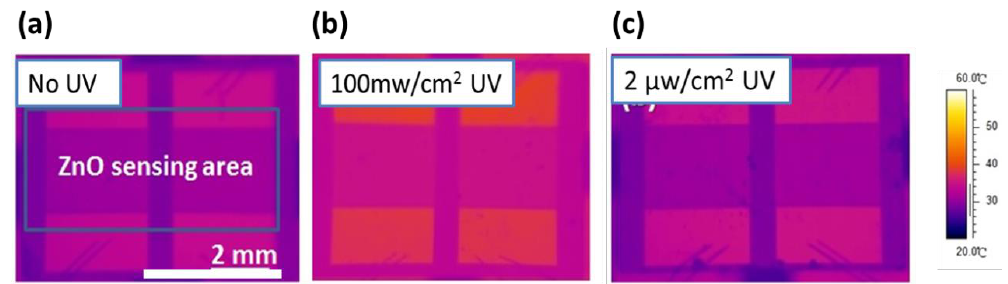
Figure 6. IR images of nanoscale coral-like detectors: ( a ) no UV illumination; ( b ) the device illuminated with 100 mW/cm 2 UV illumination; and ( c ) with 2 μW/cm 2 UV illumination.